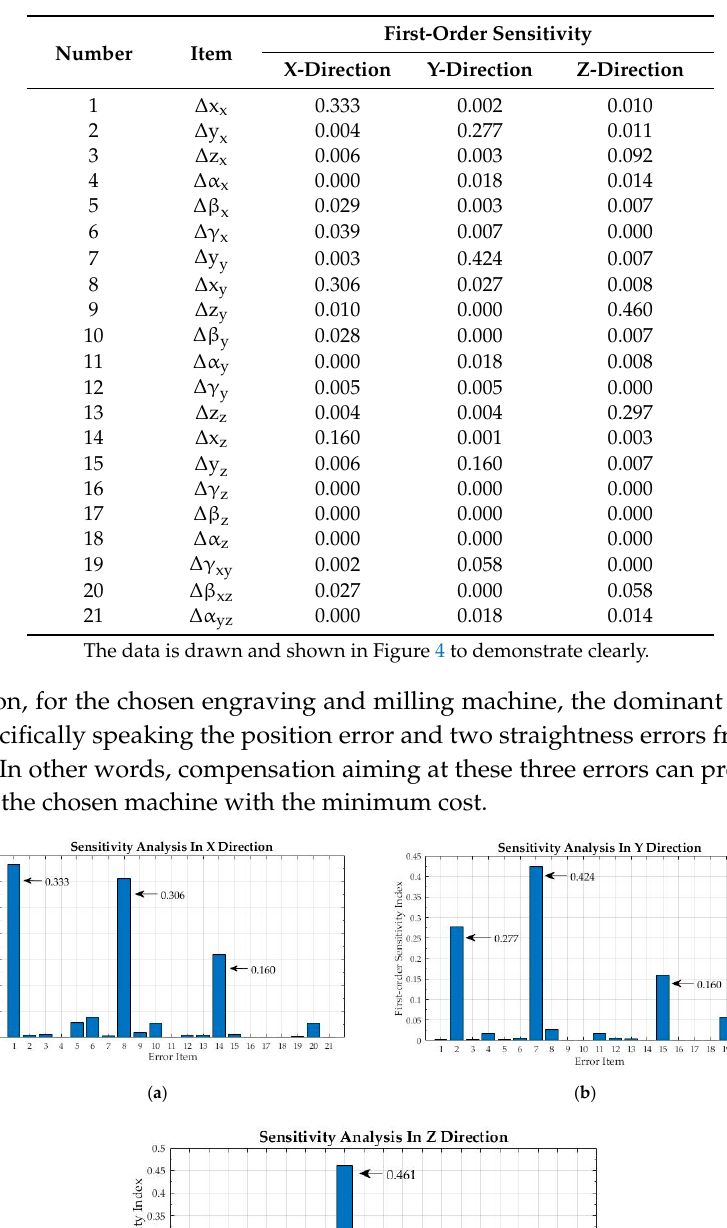
Table 6. First-order sensitivity index of each error item.